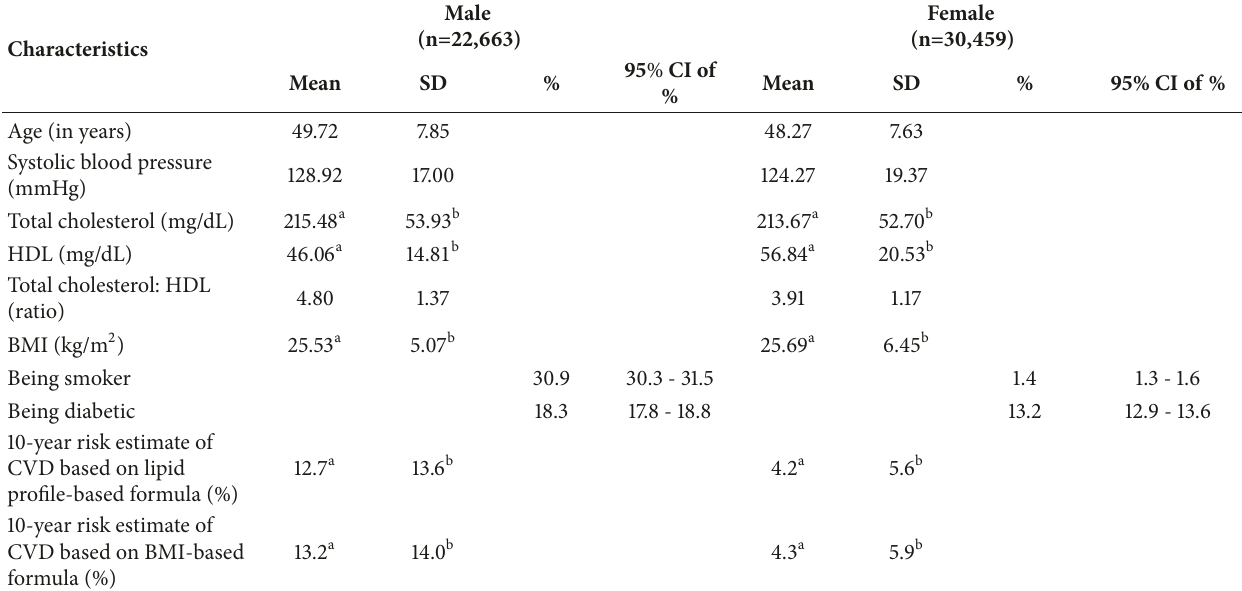
Table 1: Descriptive comparison between the genders for the Framingham Risk Score related variables based on the baseline of The Malaysian Cohort subjects, 2006-2012